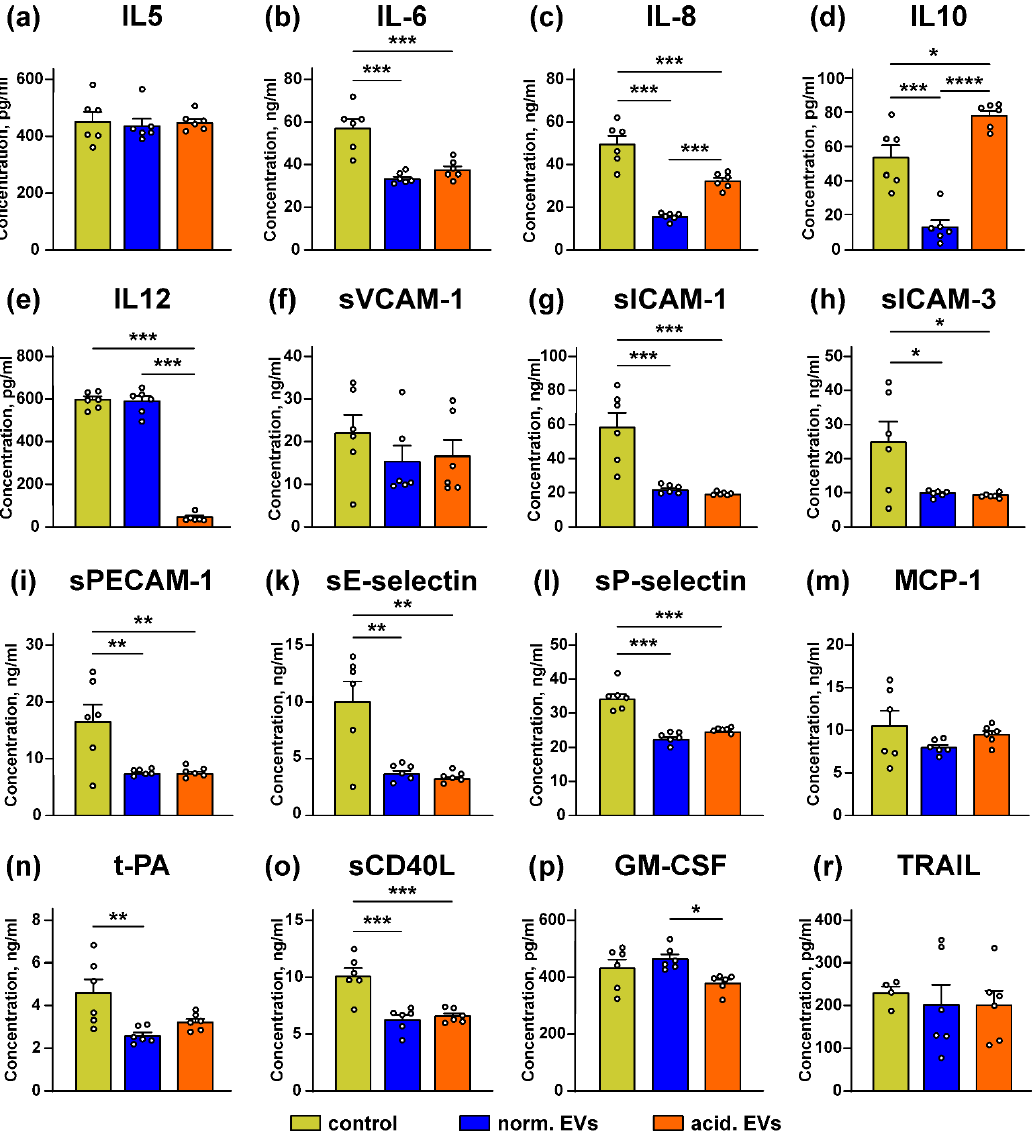
Figure 7. Effect of “normal” and “acidified” EVs on secretion of the different cytokines and adhesion factors by the keratinocytes. Het1-A cells were incubated with “normal” and “acidified” EVs for 48 h, and the concentration of IL5 ( a ), IL10 ( d ), IL12 ( e ), GM-CSF ( p ), and TRAIL ( r ) was assayed by ELISA. Concentration of IL6 ( b ), IL8 ( c ), sVCAM-1 ( f ), sICAM-1 ( g ), sICAM-3 ( h ), sPECAM-1 ( i ), sE-selectin ( k ), sP-selectin ( l ), MCP-1 ( m ), t-PA ( n ), and sCD40L ( o ) was analyzed by the Flow Cytomix kits. Data presented as the normalized protein concentration ± SEM ( n = 6). Control corresponds to the untreated cells. * ( p < 0.05), ** ( p < 0.01), *** ( p < 0.001), and **** ( p < 0.0001) indicate significant difference between the data groups by the one-way ANOVA followed by Tukey’s post hoc test.